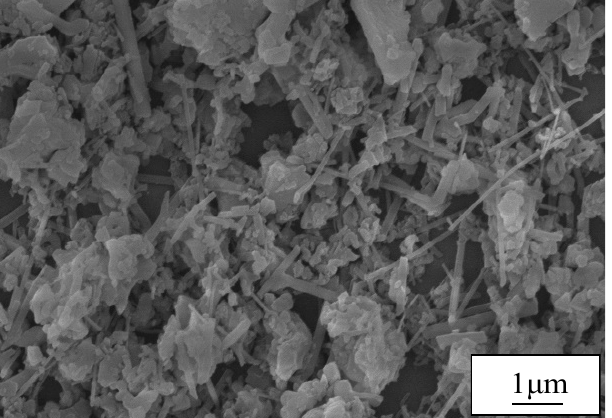
Figure 1. SEM image of SN2 sample powder before hot-pressing sintering. X-ray diffraction (XRD) phase analysis was performed on the pre-compact body and sintered body before and after hot-pressing sintering, respectively, to determine the phase change before and after sintering, as shown in Figure 2. Based on the analysis of the XRD pattern, it can be seen that the Si 3 N 4 before sintering is mainly α -Si 3 N 4 , and there is only β -Si 3 N 4 remaining in the sample after sintering, indicating that during the sintering process, the α -Si 3 N 4 in the initial powder is all converted into columnar β -Si 3 N 4 [24,25]. In addition, oxygen-containing sintering aids react with surface SiO 2 and Si 3 N 4 to form a liquid phase of oxynitride at a high temperature. That is, during the high-temperature sintering process of Si 3 N 4 , Al 2 O 3 enters the Si 3 N 4 crystal, and Al 3+ and O 2 − ions replace part of the Si 4+ and N 3 − ions in the Si 3 N 4 lattice, respectively. This forms the Si-Al-O-N (which is β -sialon) phase, Y 2 O 3 becomes Y-N apatite, and the Y-Si-O-N phase appears. The resulting liquid phase can provide a solvent for bond breaking, reconstruction, and phase transition; phase transition usually occurs only at the solid-liquid phase contact because the sintering and densification of Si 3 N 4 are affected by the solubility and viscosity of the liquid phase [26–28]. During the phase transition, the unstable and easily soluble α -Si 3 N 4 dissolves into the liquid phase, while the stable and insoluble β phase is precipitated, and this liquid phase becomes the grain boundary phase when cooled. It can be seen from XRD (Figure 2) that the TiC 0.7 N 0.3 phase exists before and after sintering. Therefore, it can